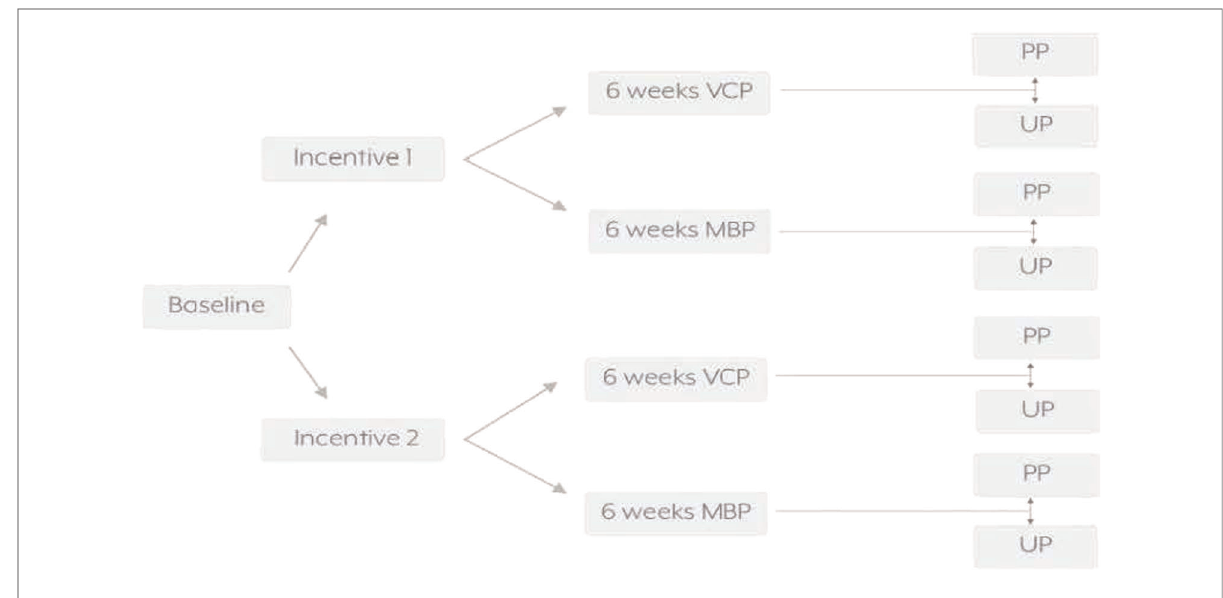
FIGURE 1 Randomization scheme for the study.